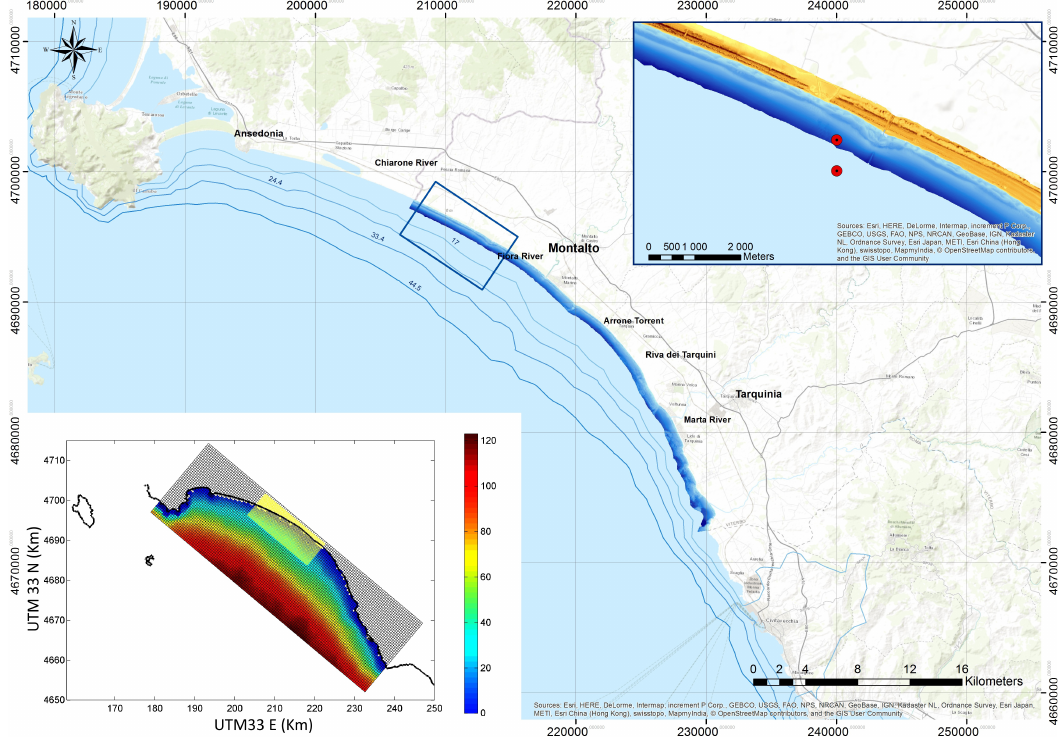
Figure 2. Montalto di Castro study area (Central Italy, Tyrrhenian Sea). The box in the bottom left report the grid of the numerical simulation (the color scale refers to the bathymetry based on EMODnet data). Both the large grid (500-m resolution) and the nested grid (250-m resolution) used for the comparison of two modeling scenarios are depicted. The box in the top right shows topo-bathymetric data used in the detailed model scenario (i.e., LiDAR data collected within the LIDLAZ project, Lidar Survey of the Lazio Province coastline, and multibeam data provided by Lazio Province). Red solid circles indicate to the points where the wave climate has been compared (the one closer to the coast refers to the detailed model